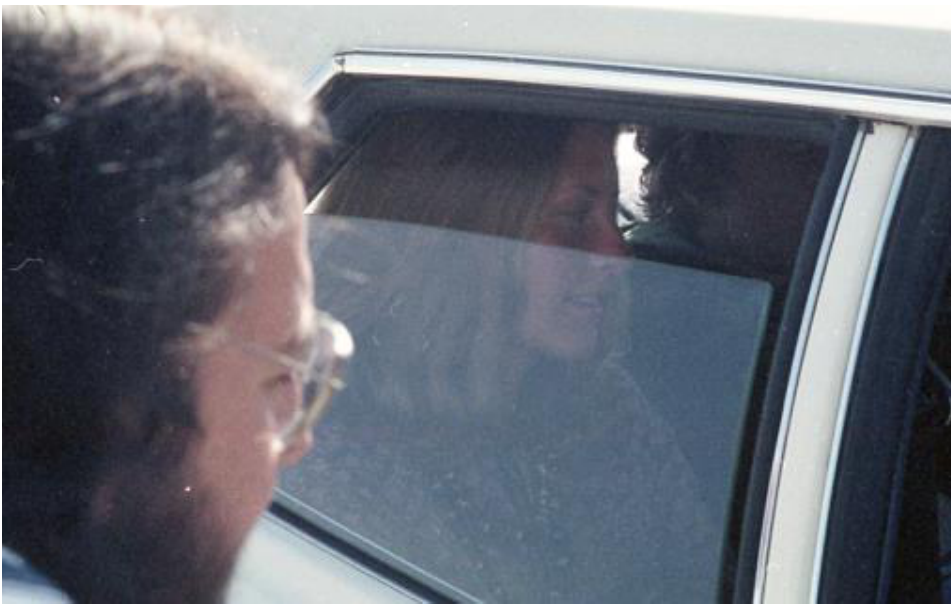
David Lamelas, The Desert People, 1974. Still of the travelers. 16mm film transferred to DVD, color, sound, 44:09 min. Installation view. Hammer Museum, Los Angeles. Purchased through the Board of Overseers Acquisition Fund. Copyright David Lamelas, images courtesy of Maccarone, Sprüth Magers, and Jan